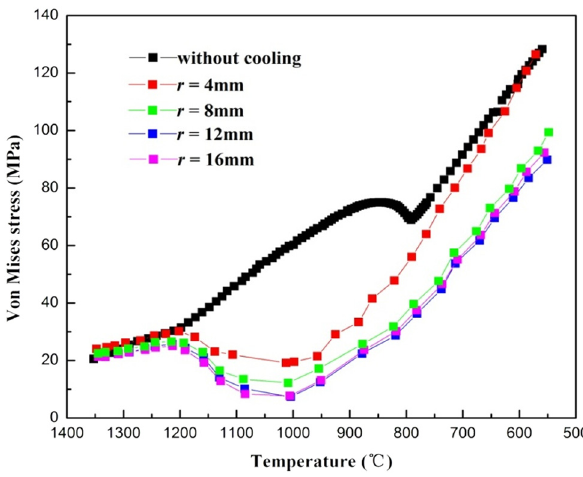
Figure 15: Transverse stress distributions along weld center line of di ff erent radiuses of trailing cooling source when t = 30 s.